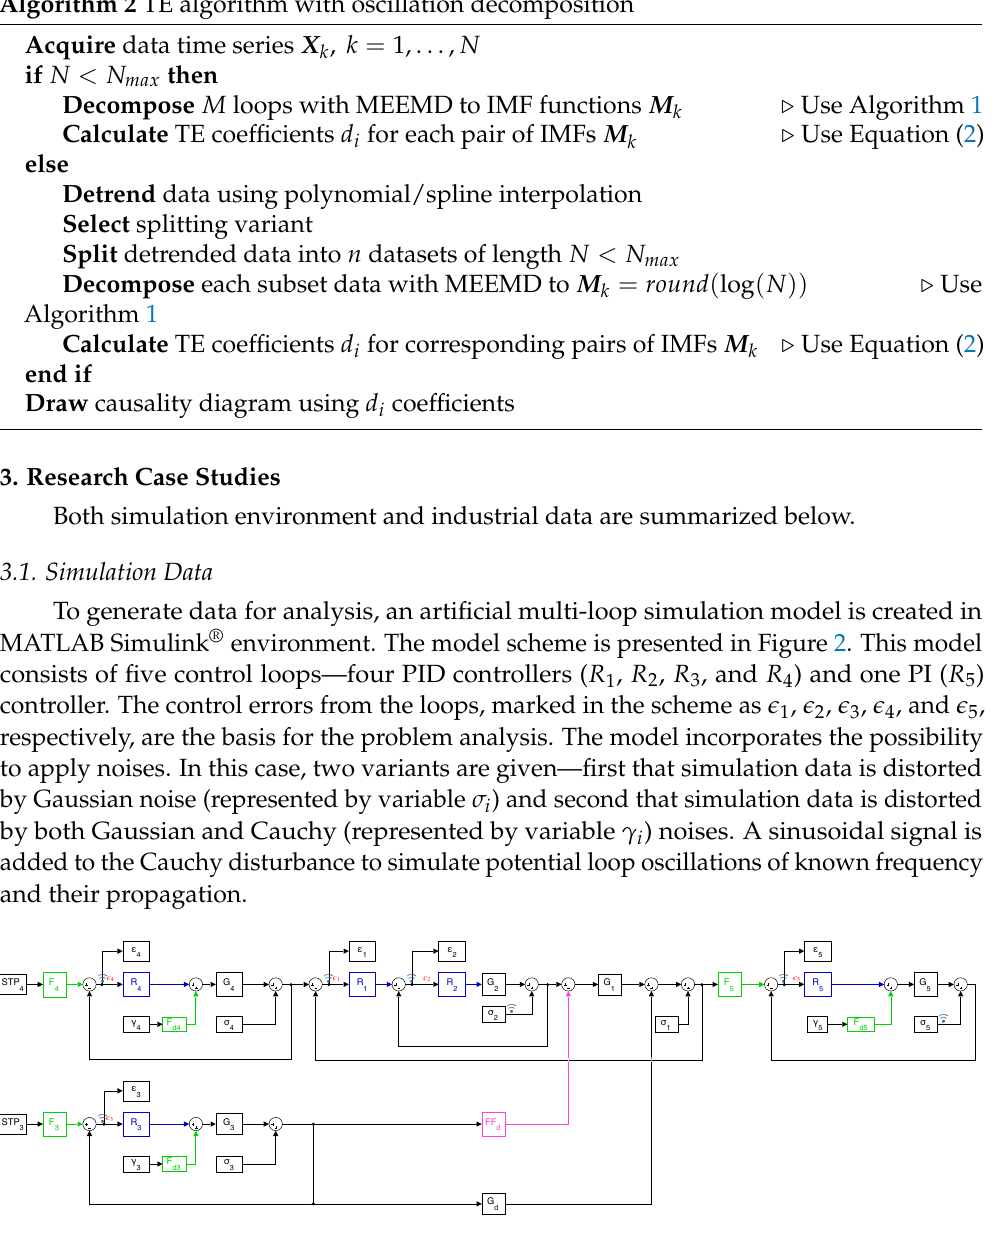
Figure 2. Simulation environment presenting multi-loop PID-based control